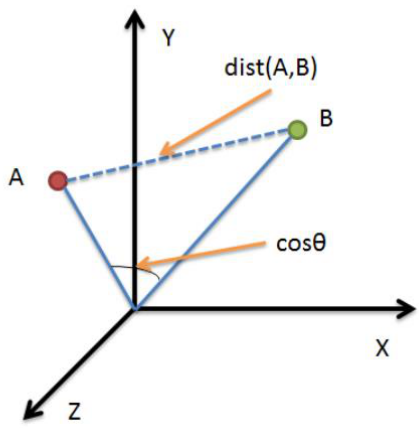
Figure 7. Calculating the distance between two points in n-dimensional space.